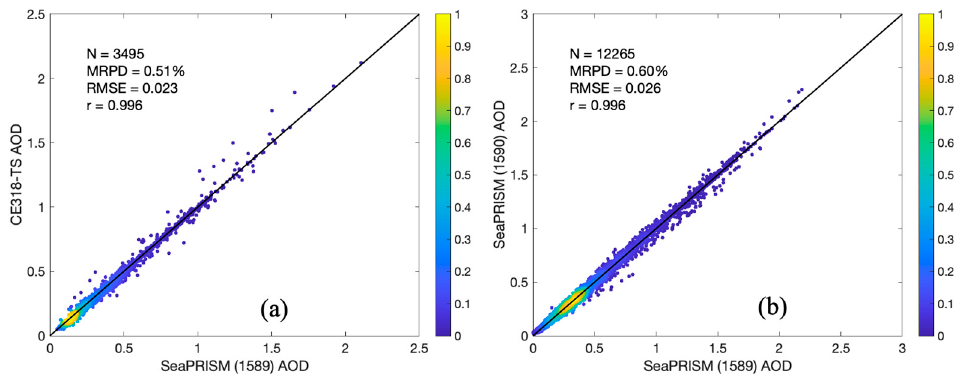
Figure 5. Density scatter plot of aerosol optical depth (AOD) between ( a ) SeaPRISM (1589) vs. CE318-TS and ( b ) SeaPRISM (1589) vs. SeaPRISM (1590). Data in ( a ) were measured before 10 June 2020 and compared at 442, 510, 667, 865, and 1020 nm. Data in ( b ) were measured after 10 June 2020 and compared at 400, 412, 442, 490, 510, 560, 620, 667, 779, 865, and 1020 nm. The statistic parameters, including the total number of matched measurements (N), median relative percentage difference (MRPD), root mean square error (RMSE), and Pearson correlation coefficient (r), are overlaid.